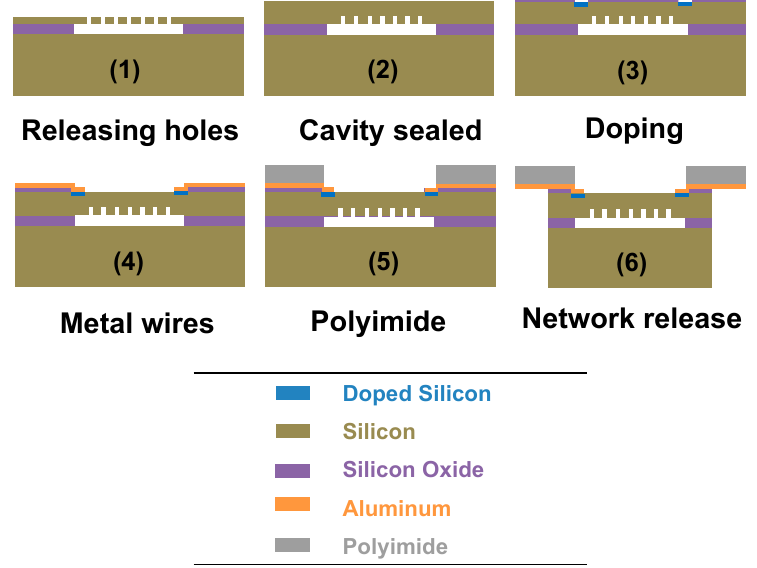
Figure 2. Main fabrication processes of the stretchable pressure sensor network.